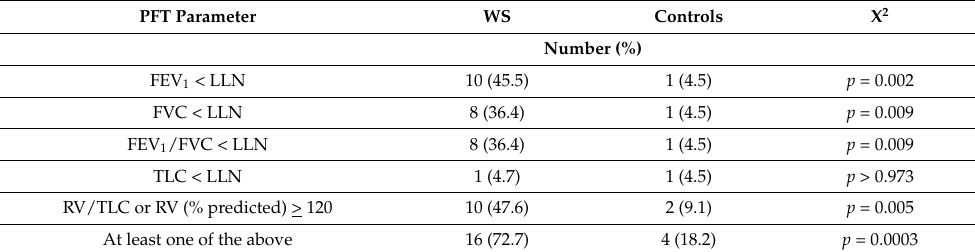
Table 2. Outcomes of pulmonary function testing reveal increased incidence of lung abnormalities in adults with WS compared to controls. FEV 1 /FVC < LLN occurs more frequently in cases compared to controls and is indicative of obstructive lung disease in patients with that finding. RV/TLC > 120% is more common in adults with WS compared to controls and suggests that air trapping is more common in cases. Overall, patients with WS had more findings of lung abnormalities than control counterparts. X 2 tests were performed for all variables indicated. Abbreviations: FEV 1 : forced